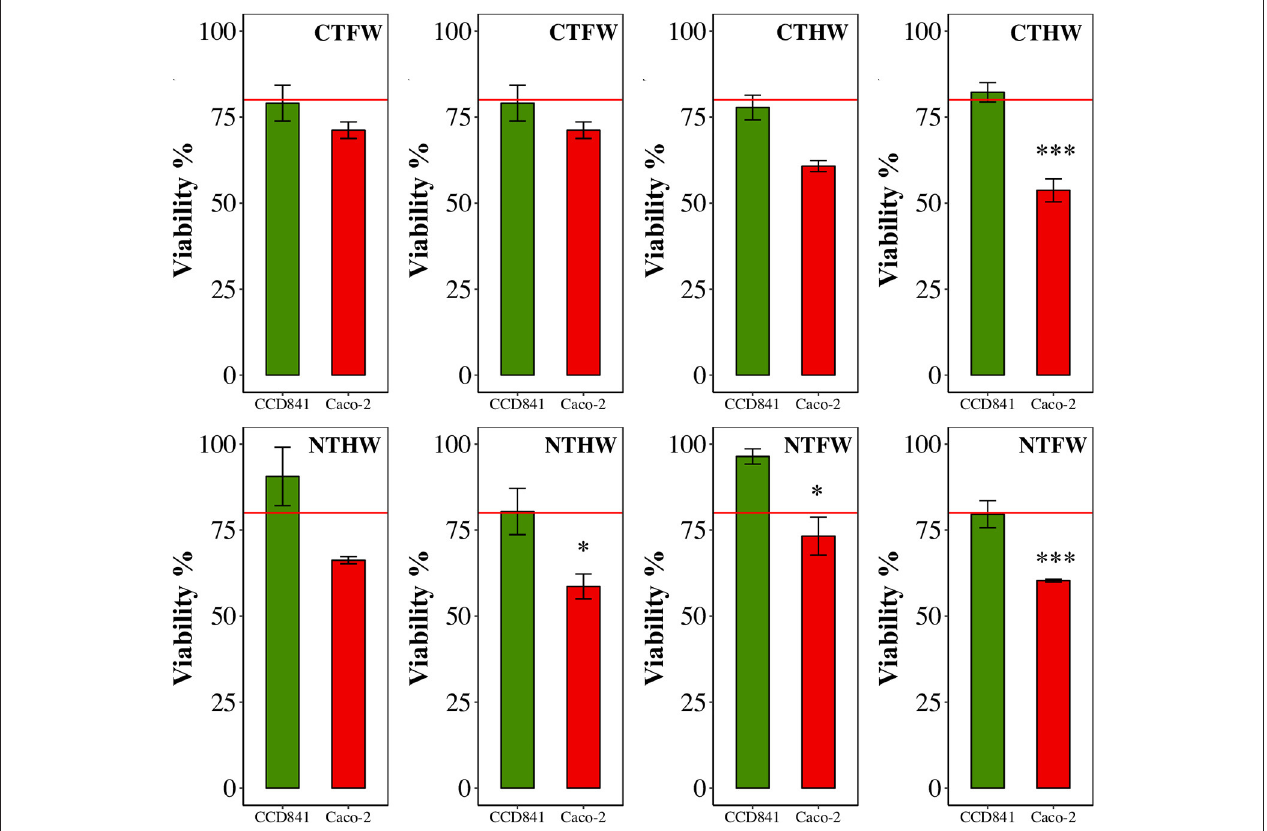
FIGURE 2 | MTT viability assay on two human: cell lines: CCD841 (green, healthy line) and Caco-2 (red, colorectal cancer cell line). All cell lines were treated with 100 µ g/mL GAE in the medium. Data are mean ± SEM. * p < 0.05, ** p < 0.01, *** p < 0.001. CTFW, conventionally tilled and fully watered plots; CTHW, conventionally tilled and half-watered plots; NTHW, not-tilled and half-watered plots; NTFW, not-tilled and fully watered plots.